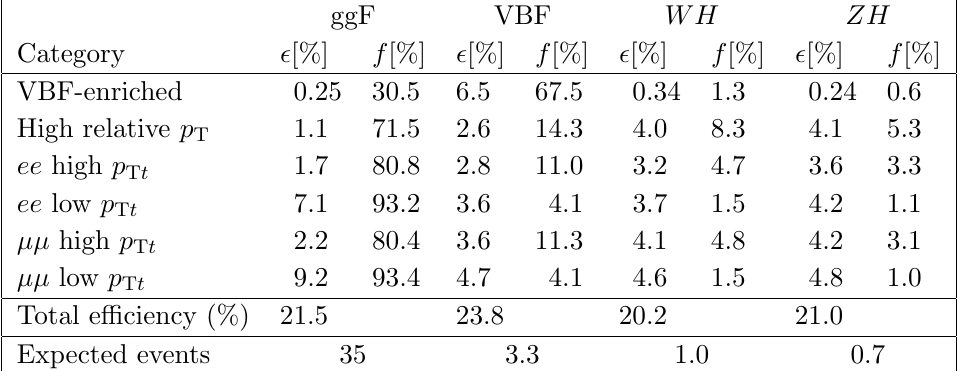
Table 2 . The expected signal e(cid:14)ciency times acceptance, denoted by (cid:15) , per production mode for each category after the full event selection, as well as the expected fraction f of each production process relative to the total signal yield, for simulated SM Higgs boson production assuming m H = 125 GeV. The expected number of signal events per production process is also